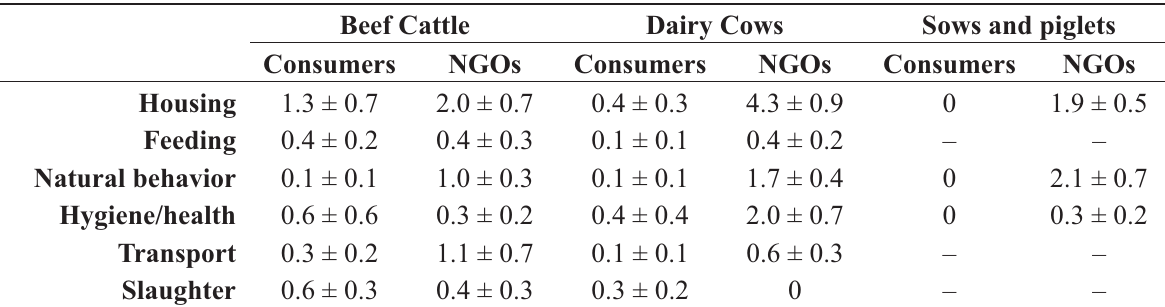
Table 4. Average (±standard error) number of issues, for beef cattle, dairy cows, and sows, and piglets, contained within each of the main animal welfare topics, that were cited